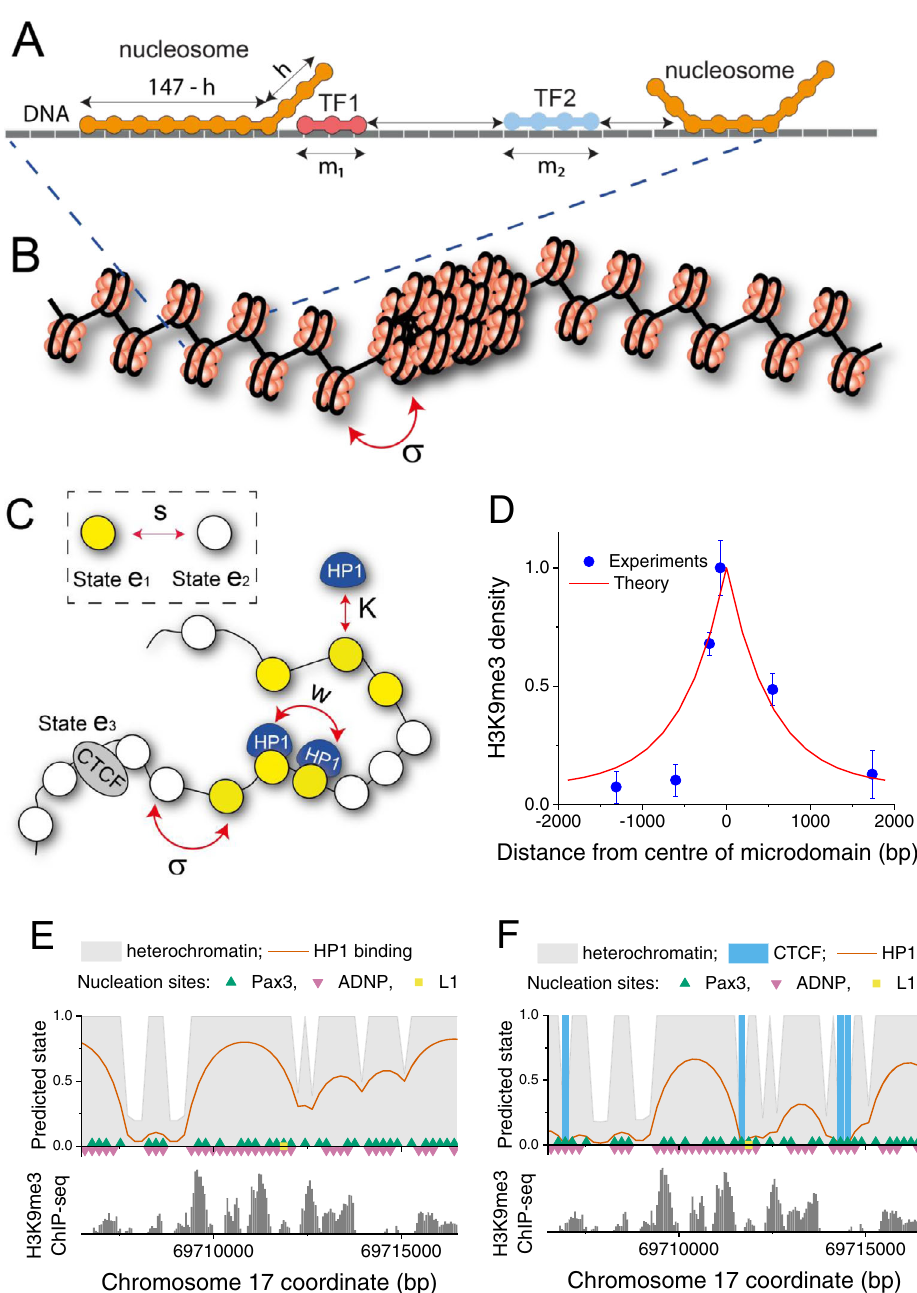
Fig. 2 ChromHL framework for HND description. A A lattice model with single-base pair resolution for TF binding to DNA in the context of nucleosomes that can partially unwrap. B Schematic representation of the nucleosome array containing two types of packing. The boundary between different chromatin states is characterised by the statistical weight parameter σ . It could re fl ect that inter-nucleosome interactions in different packing states are different and thus create a boundary between them. C Description of chromatin in ChromHL. Chromatin is described by a lattice of nucleosome units. These lattice units can exist in different states. In the present study, three states e 1 , e 2 and e 3 exist that correspond to a H3K9me2/3 modi fi ed nucleosome, an unmodi fi ed nucleosome or a unit without a nucleosome but with CTCF bound. Lattice units can switch between different states with probability s ( e 1 , e 2 ). Chromatin proteins can shift this equilibrium by binding nucleosomes with different binding constants K ( e,g ) depending on the protein type g and the chromatin state e of a given lattice unit while interactions between proteins bound to neighbouring lattice units is described by the cooperativity parameter w . D H3K9me3 pro fi le predicted by ChromHL in comparison to experimentally determined data in mouse embryonic fi broblasts for an ectopic HND 14 , with best fi t parameters s = 7.1e − 3, σ = 1.16e − 5, w = 8.25e3. The mean occupancy (normalised so the maximum occupancy is 1) is shown, along with bars showing standard deviation from two biological replicates. E Model predictions (top panels) and experimental ChIP-seq pro fi les of endogenous H3K9me3 (bottom panels) for an example genomic region in ESCs. This model includes HND nucleation at PAX3/9, ADNP and L1 sequence motifs, but does not consider CTCF binding. In this calculation σ = 1, and therefore the main determinants of HNDs are the nucleation sites in the DNA sequence. F Same as panel E but including CTCF binding as a factor that determines HND boundaries. Including CTCF improves the agreement of the predicted HND pro fi le with the experimental